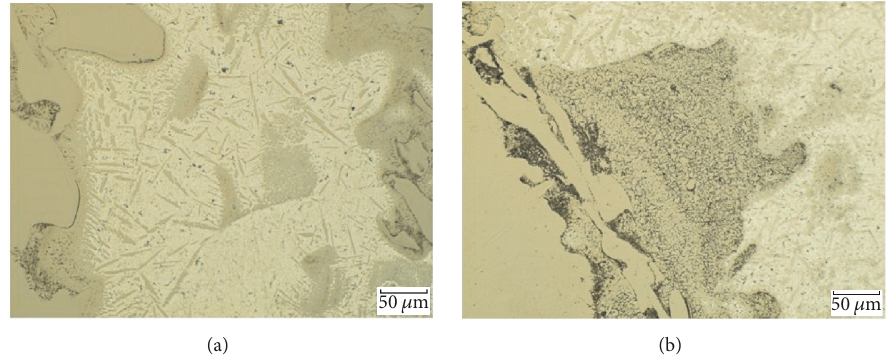
Figure 19: Microstructure of the weld metal for (a) sample 3 and (b) sample 4.